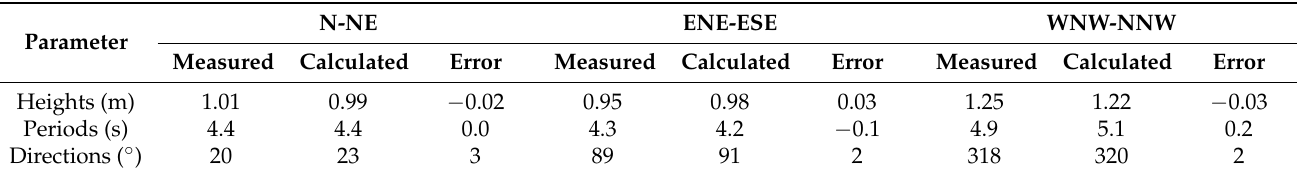
Table 1. Representative and simulated waves’ parameters.